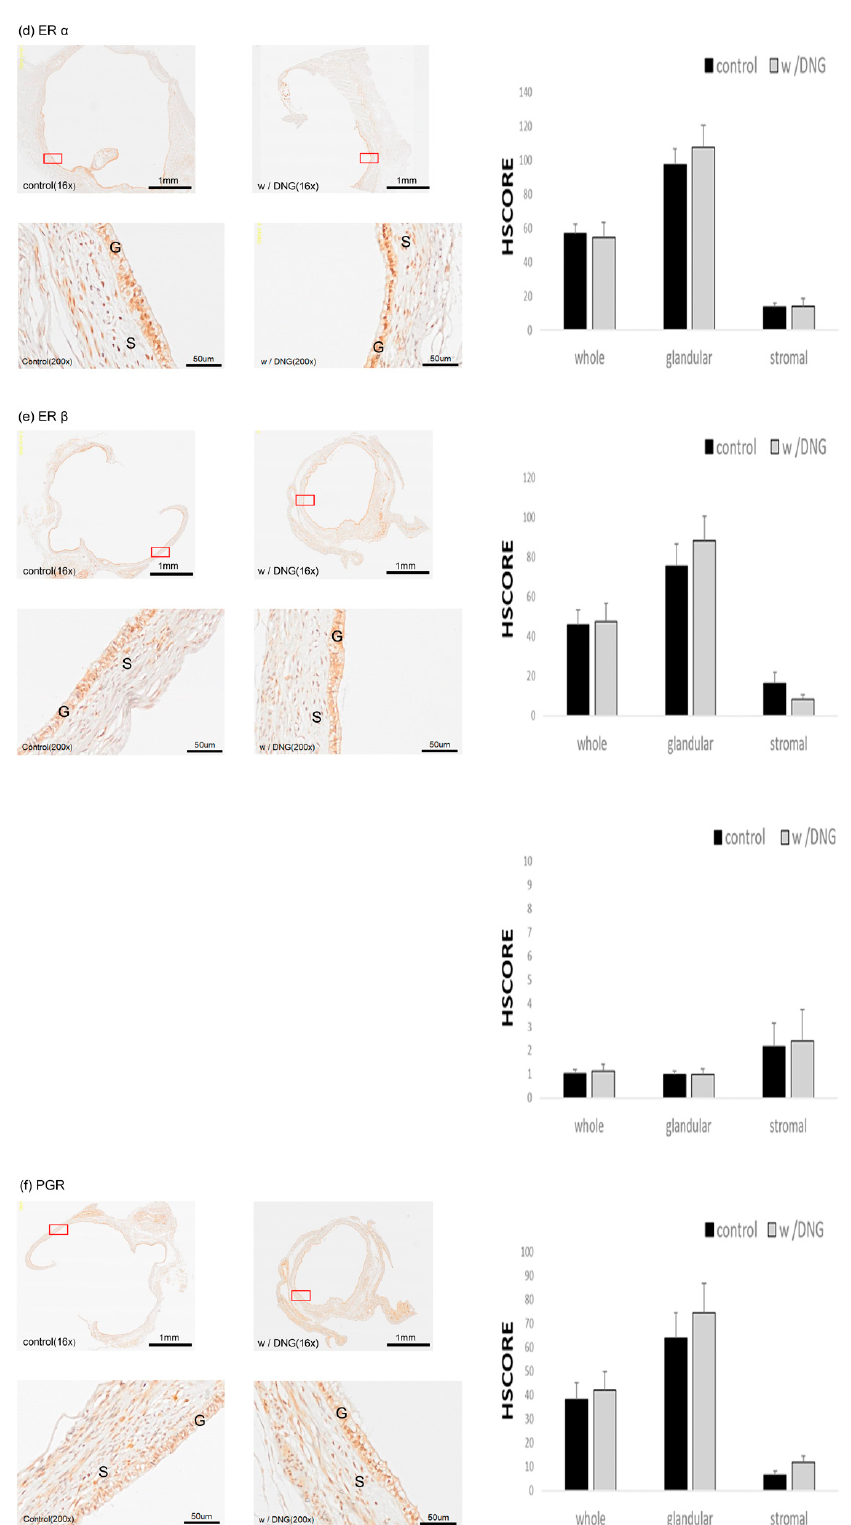
Figure 6. Effects of DNG treatment in mouse model. Representative immunostaining micrographs ( × 16 and × 200) and HSCOREs for ( a ) proliferating cell nuclear antigen (PCNA), ( b ) Ki-67, ( c ) Krüppel- like factor 9 (KLF9), ( d ) estrogen receptor (ER) α , ( e ) ER β and ER β /ER α ratio, and ( f ) progesterone receptor (PGR) in allotransplanted endometrial tissues of mice treated with or without DNG. Values are expressed as the mean ± SEM. * p < 0.05 vs. control. G—glandular portion, S—stromal